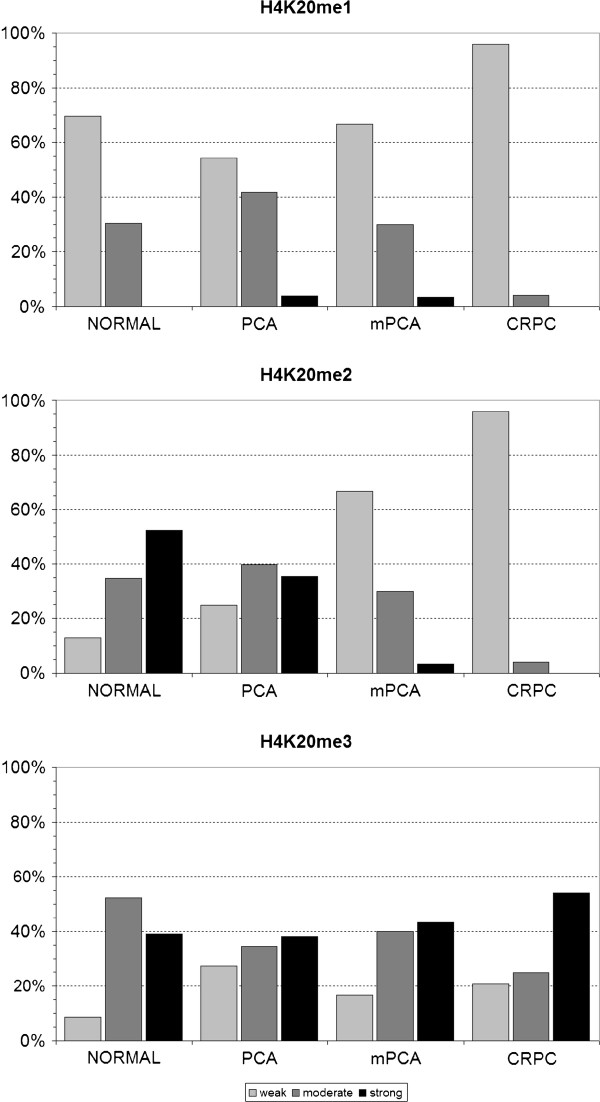
The columns show the distribution of the different global H4K20 methylation levels in non-malignant prostate tissue (n = 23), localized prostate cancer (PCA; n = 113), metastatic hormone-naïve prostate cancer (mPCA; n = 30) and castration-resistant prostate cancer (CRPC; n = 34). H4K20 methylation levels were categorized into weak (≤ 4), moderate (5-8) and strong (≥ 9).